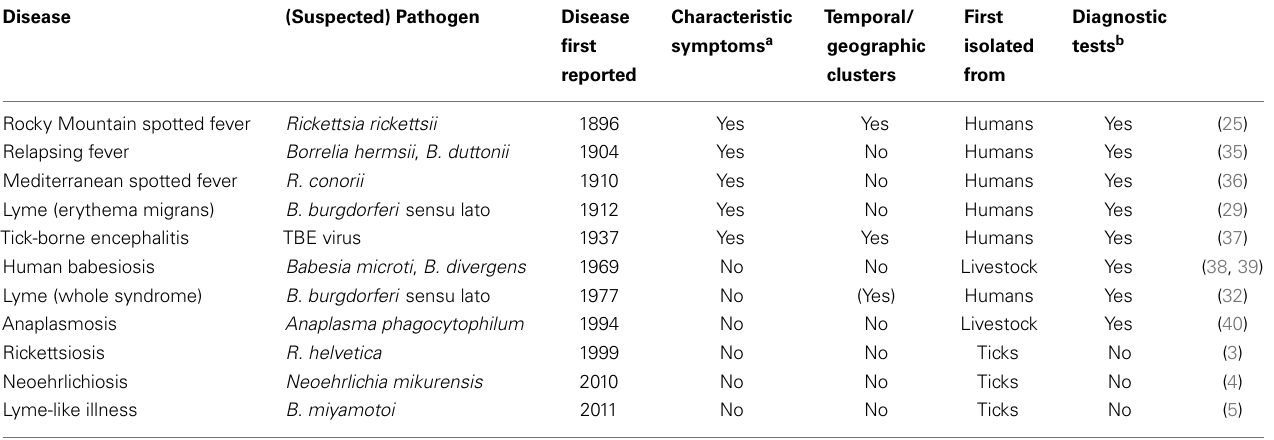
Table 1 | Selection of tick-borne diseases in humans and characteristics associated with their discovery